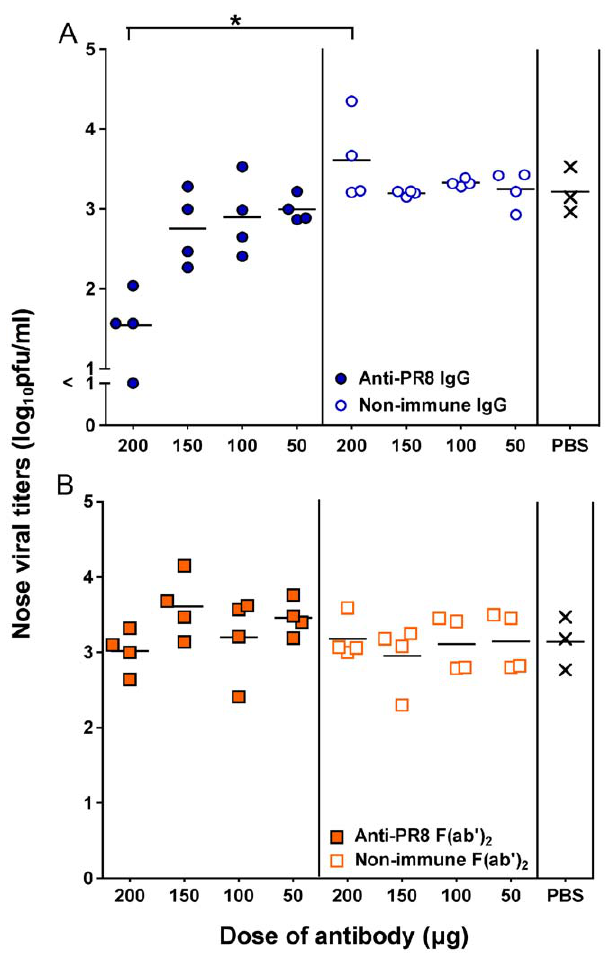
Figure 2. Virus loads are reduced in the nasal turbinates after treatment with the anti-PR8 IgG preparation. Unanesthetised BALB/c mice (n=4) were given 500 pfu of PR8 virus in 10 m l by the intranasal route to establish a localised URT infection. Twenty four hours post-infection, mice were treated with 200 m g, 150 m g, 100 m g or 50 m g of (A) anti-PR8 IgG or non-immune IgG or (B) anti-PR8 F(ab’) 2 or non-immune F(ab’) 2 or PBS via the URT route. Five days post-infection, mice were killed and nasal turbinates were collected in 1 ml media. Viral titers were determined by plaque assay on MDCK cell monolayers. The experiment was performed once with 4 mice per group, the organs assayed in quadruplicate and titers averaged to provide a value for that animal. Each symbol represents an individual mouse and the line represents the mean of each group. The bracket with an asterisk indicates a statistically significant difference between the indicated groups.